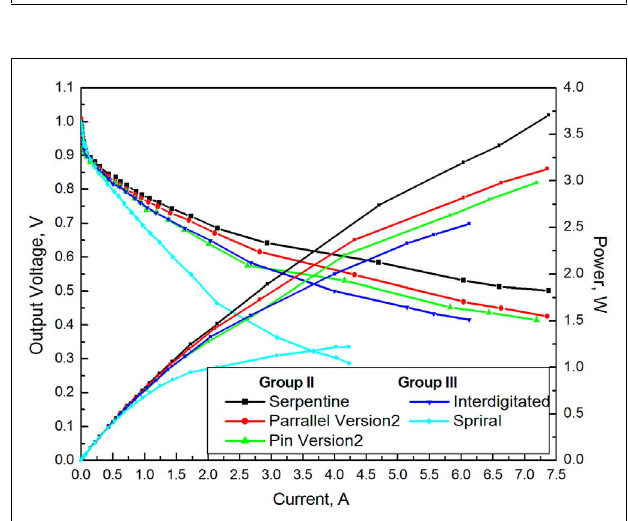
FIGURE 6 | Comparison of cell output performance between group II and group III flow field designs